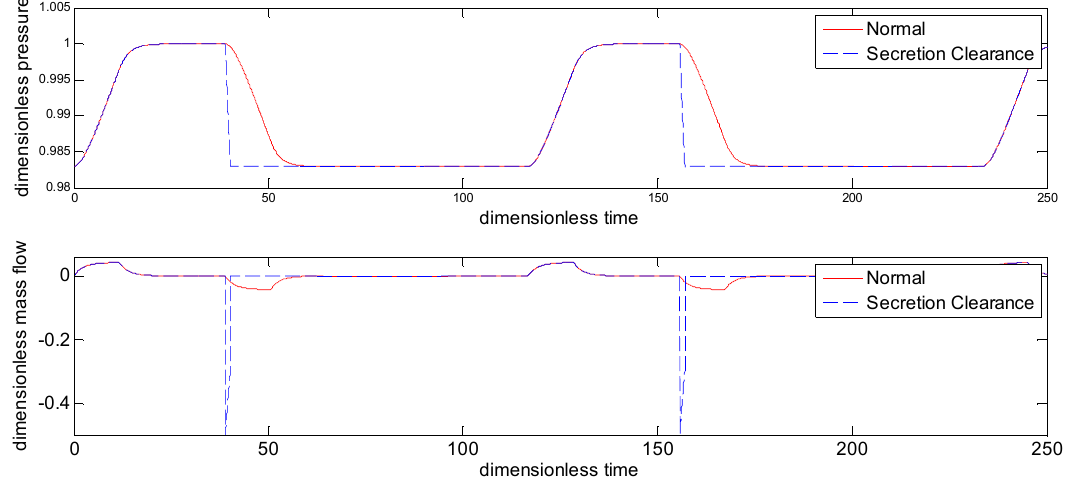
Figure 6. Comparison between normal operation and the secretion clearance function.